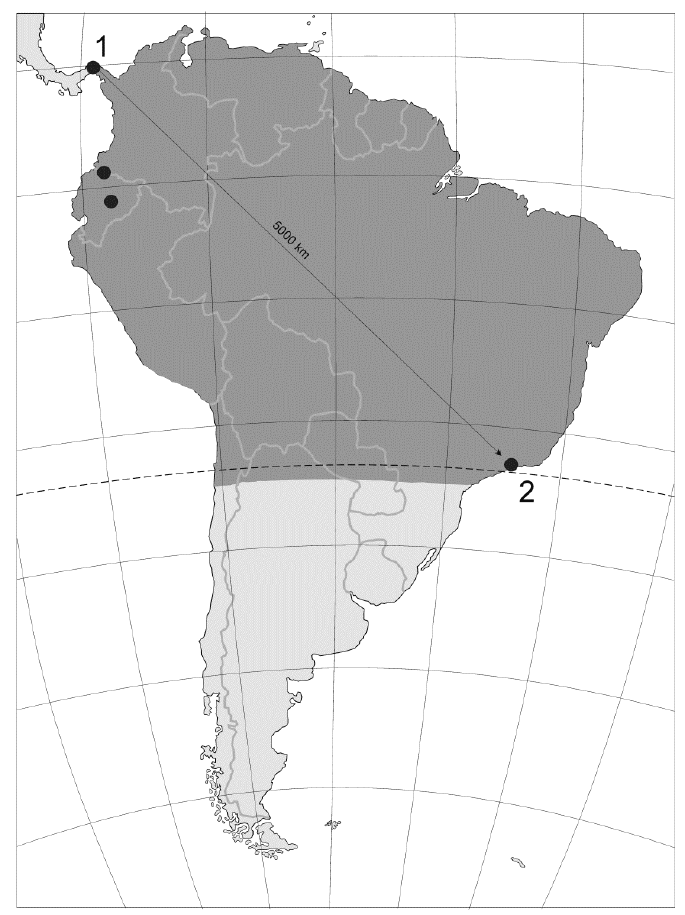
Figure 11. Distribution of recorded sites with Penicillaturopoda pennicillata ; 1—specimens described by Hirschmann and Zirgiebl-Nicol in 1969 as Uropoda ( Phaulodinychus ) penicillata ; 2—specimens described by Hirschamnn in 1972 as Uropoda ( Phaulodinychus ) penicillatasimilis ; ● —unmarked sites on which soil samples were collected in Ecuador in 2014. Gray colour is used to mark areas with potential occurrence of species.